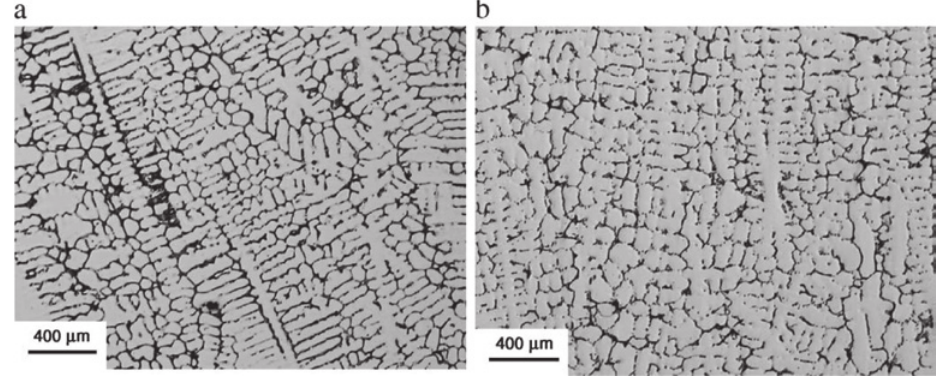
Fig. 3: Light optical micrographs of both alloys in the as-cast condition, (a) alloy HP-Nb; (b) alloy HP-NbTi [5].